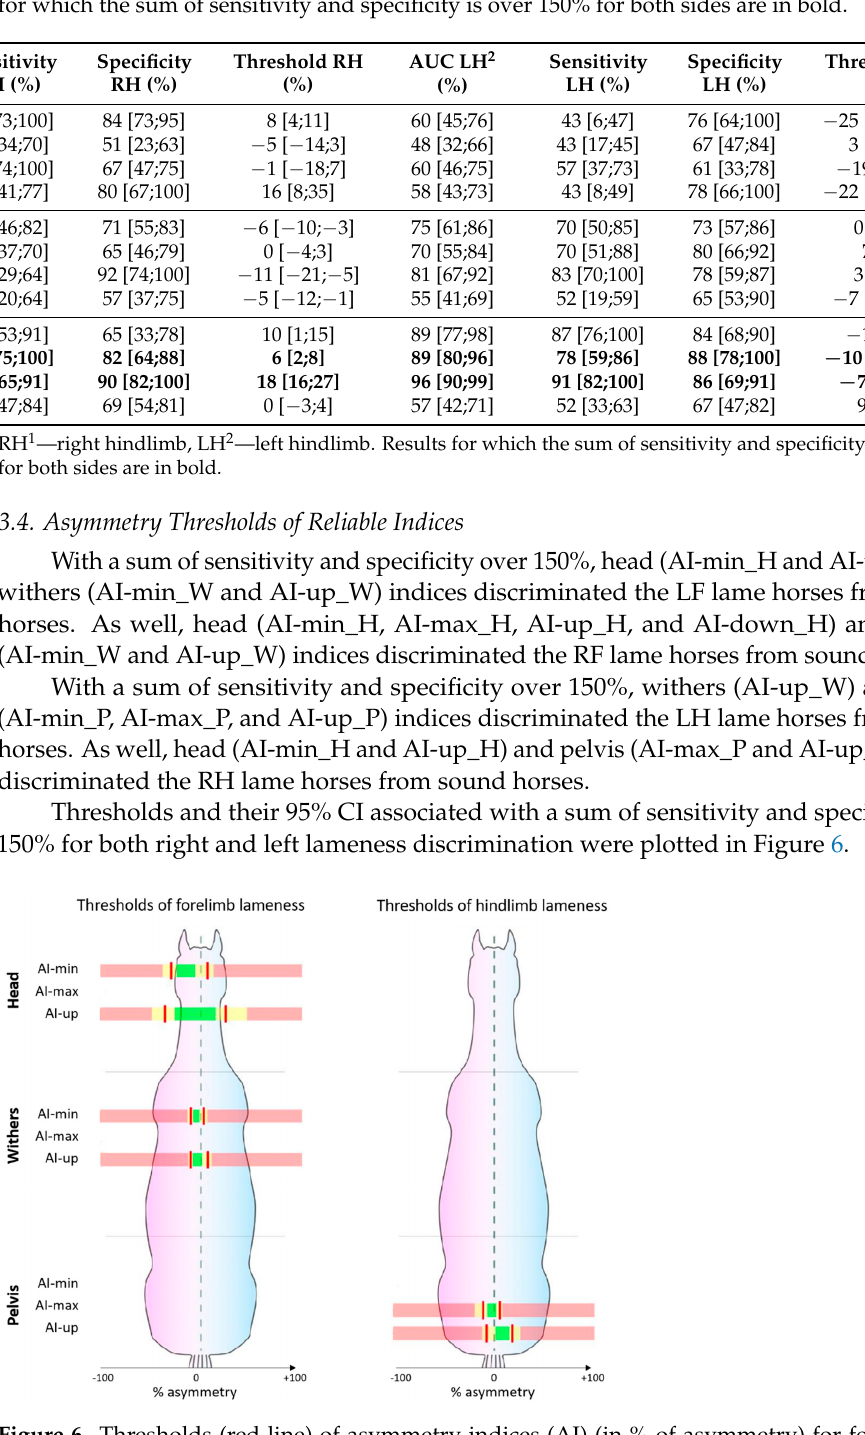
Table 4. Area under the curve (AUC) of the receiver operating characteristic (ROC) curve discrimi- nating sound and hindlimb lame horses, for each asymmetry indice (AI). Best sensitivity, specificity and associated threshold were calculated using top-left method of ROC analysis. [95% Confidence Interval] were calculated plotting ROC analysis on 400 population resamplings (bootstraps). Results